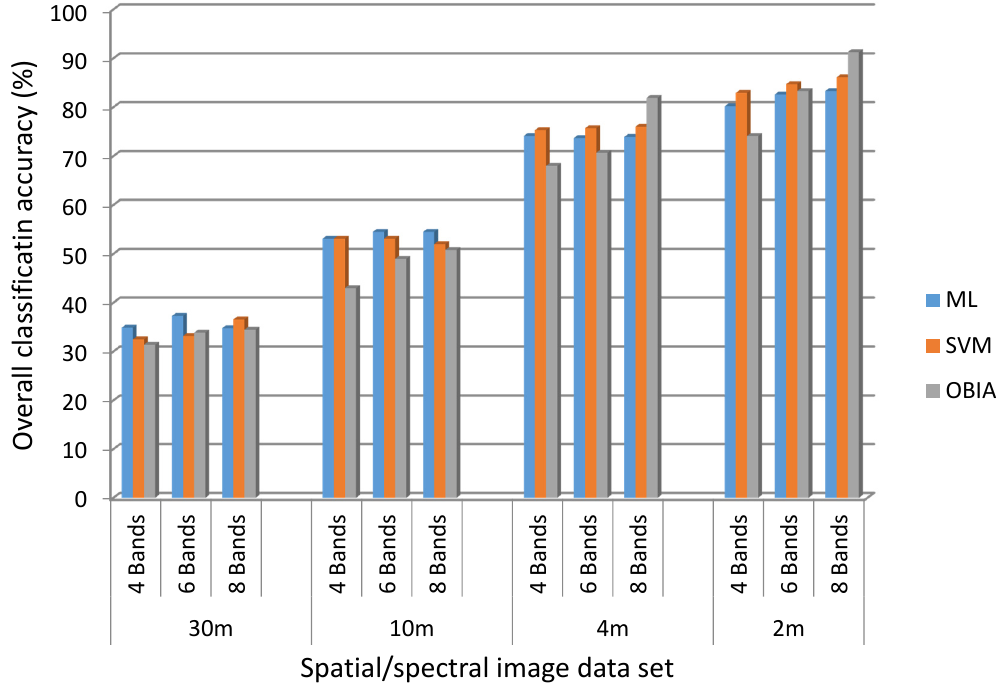
Figure 6. Overall land cover classification accuracies for the 36 data set/classifier combinations (ML = maximum likelihood, SVM = support vector machine, OBIA = object-based image analysis).